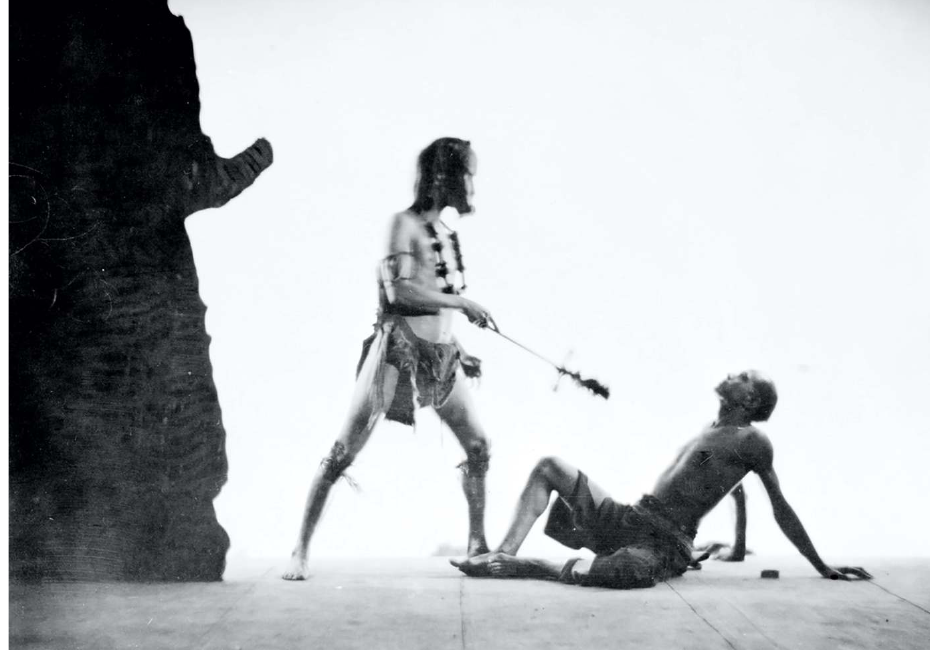
Credit: The Beinecke Rare Book and Manuscript Library. Source: https://www.pbs.org/wgbh/